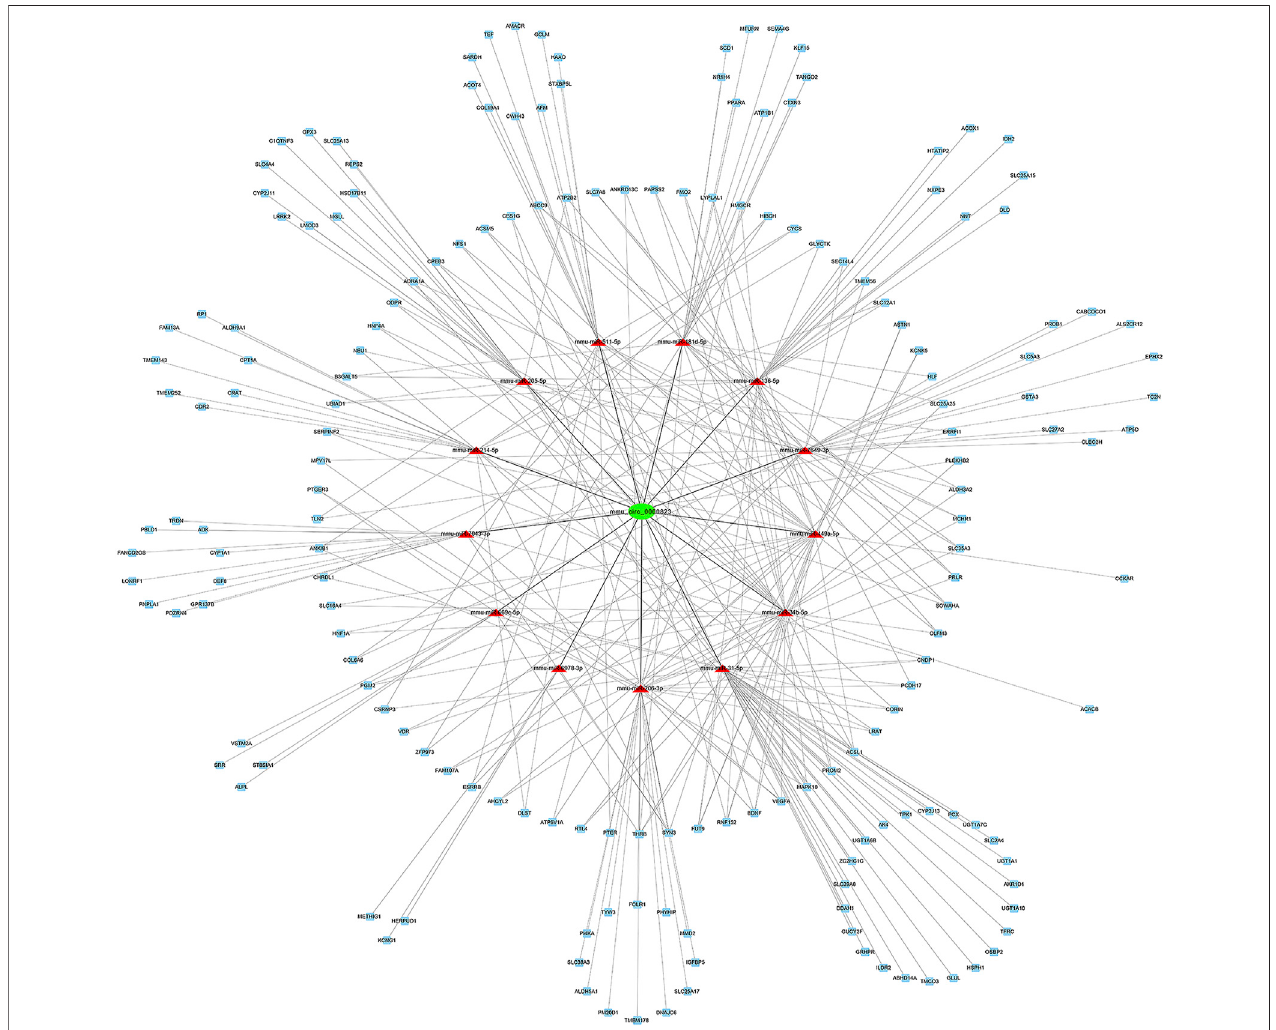
FIGURE6| Thepredicted mmu_circ_0000823 targeted ceRNA network. Thecolorsofgreen and blue nodes representthe expression levels ofthe DEgenesthat were downregulated, while the red nodes represent the upregulated genes. mRNAs in the outer circle can be regulated by a single miRNA, while mRNAs in the inner circle can be targeted by multiple